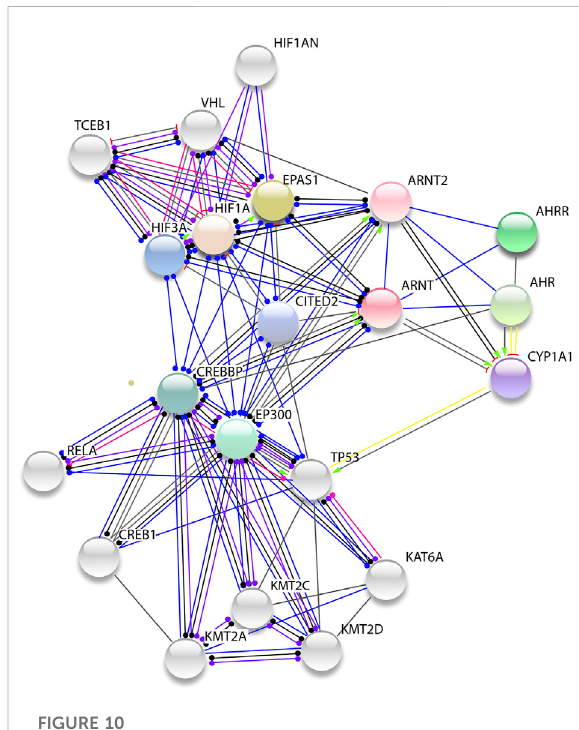
FIGURE 10 Protein-protein network of ARNT. The genes show